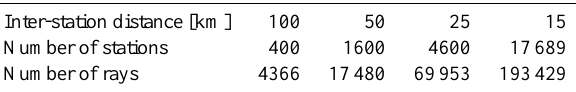
Table 1. Total number of stations within a 2000 × 2000km GPS network for inter-station distances between 100km and 15km. The number of rays is the mean value over a 12h cycle considering all possible views ( ε ≥ 0 ◦